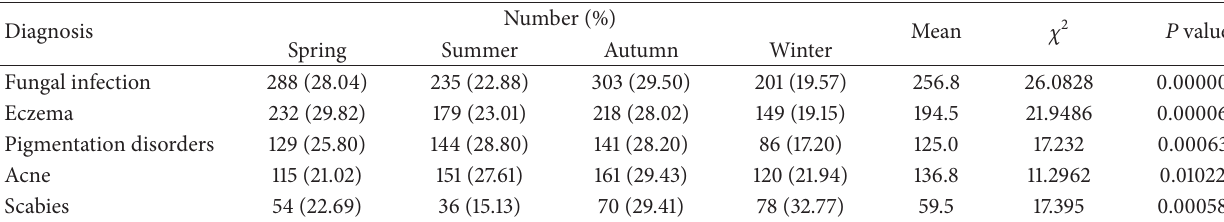
Table 3: Seasonal trend of five common dermatoses.